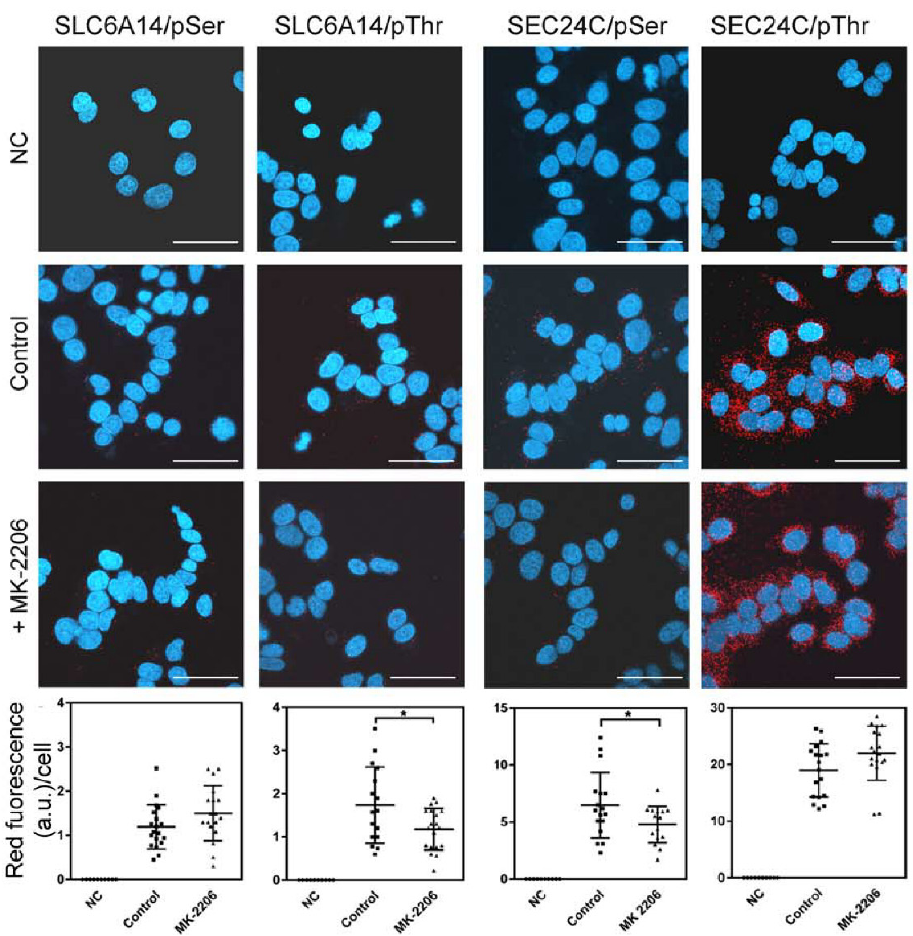
Figure 6. PLA analysis detecting phosphorylation on the serine and threonine moieties of endogenous SLC6A14 and SEC24C in breast cancer cells. MCF-7 cells were treated, where indicated, for 1 h with 5 µM MK-2206, then fixed and subjected to PLA analysis. The following primary antibodies were used: biotin rabbit anti-SLC6A14 antibody (1:250) with either mouse anti-phosphoserine (1:250) or mouse anti-phosphothreonine (1:200), and rabbit anti-SEC24C (1:250) with either mouse anti-phosphoserine (1:250) or mouse anti-phosphothreonine (1:200), as indicated. The presence of phosphorylated amino acid in the studied protein is visualized via the red dots, while nuclei are shown in blue. NC, negative control; PLA, without the primary antibodies. The representative images out of 2 independent cell cultures subcultured in 3 different coverslips each are shown. The selected images come from the same passage. Bar: 40 µm. The summarized results of the PLA assays are shown below. Statistical significance compared to the control at * p < 0.05.